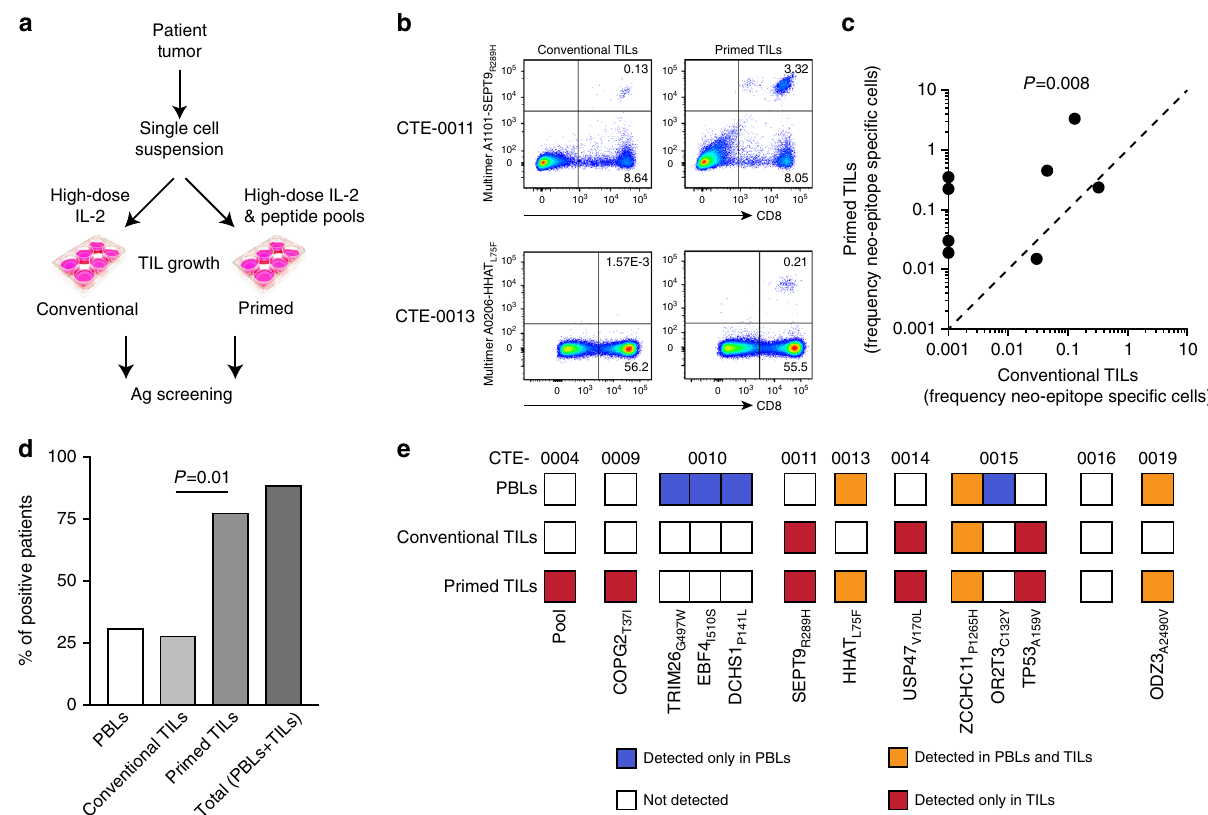
Fig. 3 TIL cultures can be enriched for neo-epitope speci fi c T cells. a Schematic representation of the alternative procedures for TIL expansion. Single cell tumor suspensions were plated in the presence of high-dose IL-2 alone (conventional TILs) or alternatively, in the presence of high-dose IL-2 supplemented with pools of predicted mutated peptides (primed TILs). b Representative examples of conventional and primed TILs, interrogated for the presence of neo- epitope speci fi c TILs by multimer staining. c Cumulative analysis of the frequencies of neo-epitope speci fi c CD8 + T lymphocytes detected in conventional ( x- axis) and primed ( y -axis) TIL cultures. d Proportions of patients with documented neo-epitope speci fi c T-cell responses in the different compartments and within the distinct TIL culture conditions. e Landscape of neo-epitope speci fi c T-cell responses in circulating, conventional TILs and primed TILs in nine patients for which primed TILs were available. T-cell responses against mutated epitopes identi fi ed exclusively in PBLs (blue), in TILs (red), in both the compartments (orange) or in none of them (white) are under the conventional expansion protocol (Fig. 3b, bottom panels and Supplementary Fig. 3).